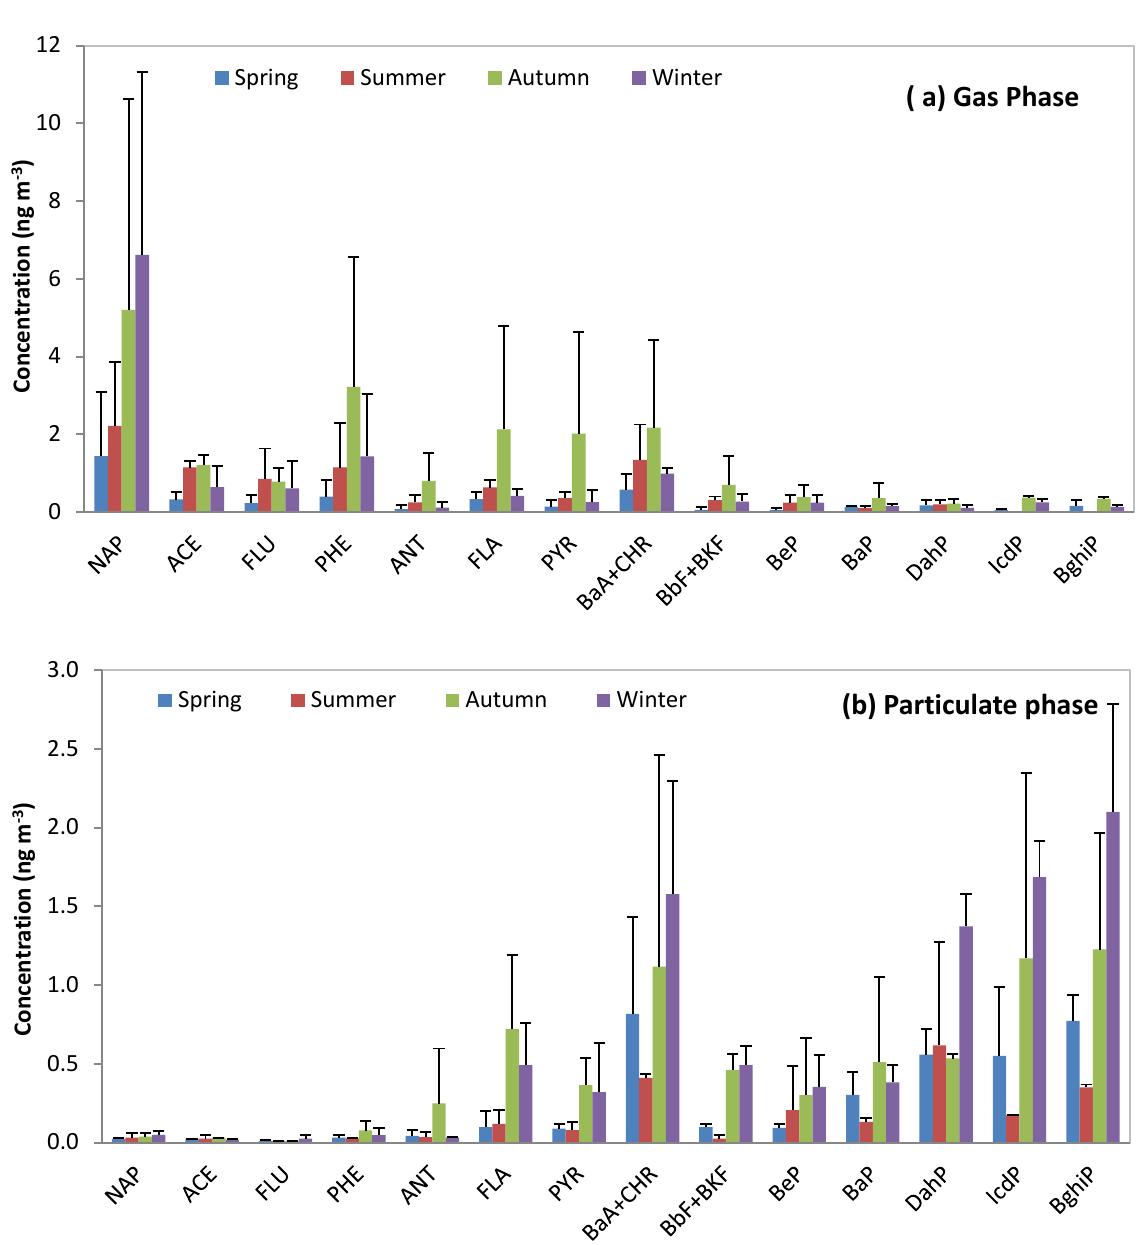
Figure 4. Mean concentration in the gas ( a ) and particulate phase ( b ) for each PAH for each season. Error bars represent the standard deviation of the mean compound concentration for all samples in each season.